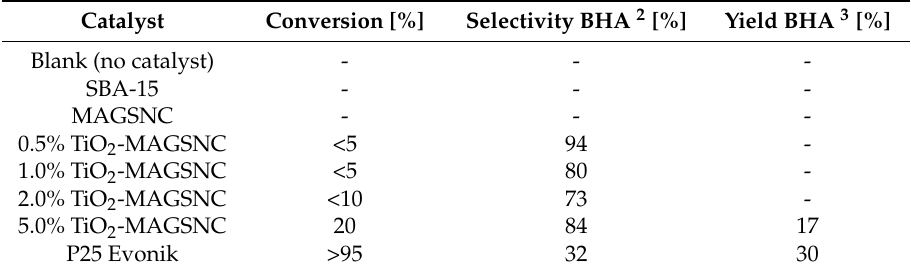
Table 4. Photocatalytic oxidation of benzyl alcohol to benzaldehyde 1